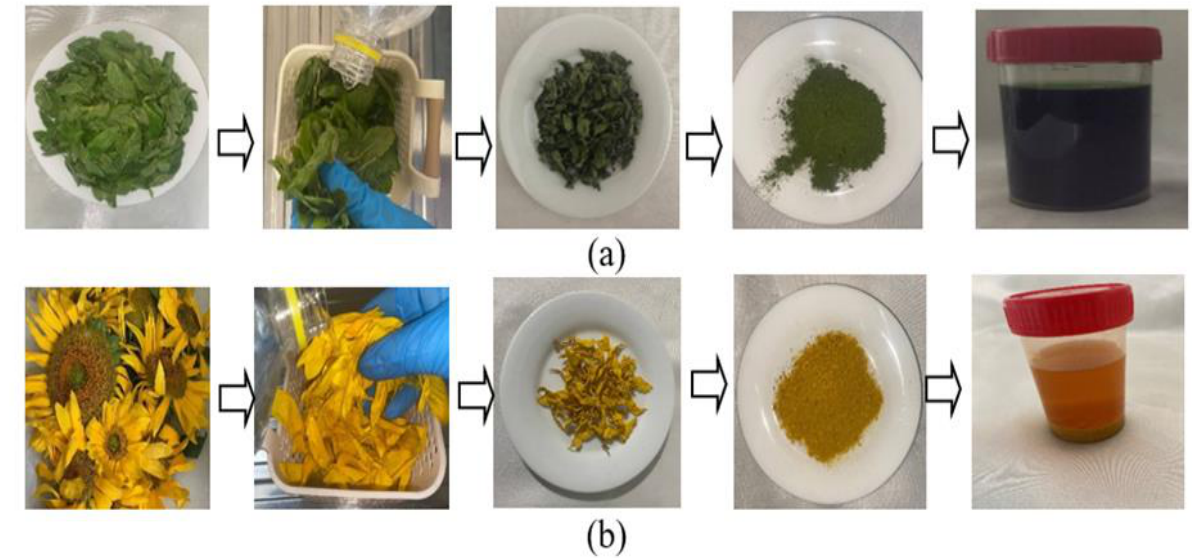
Figure 1. Steps for extracting dye from ( a ) Mentha leaves; ( b ) Helianthus annuus.